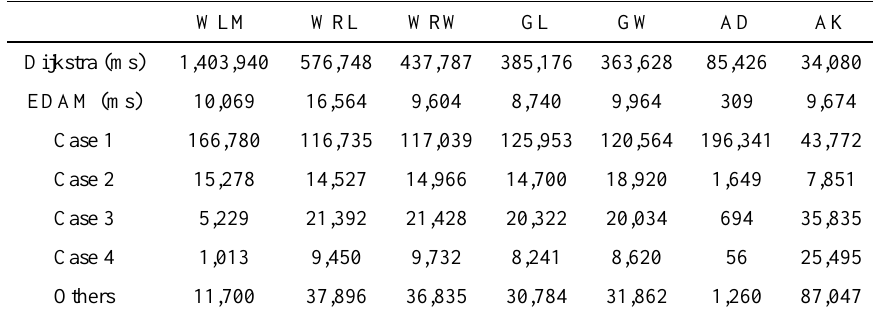
Table 1. The time performance of the